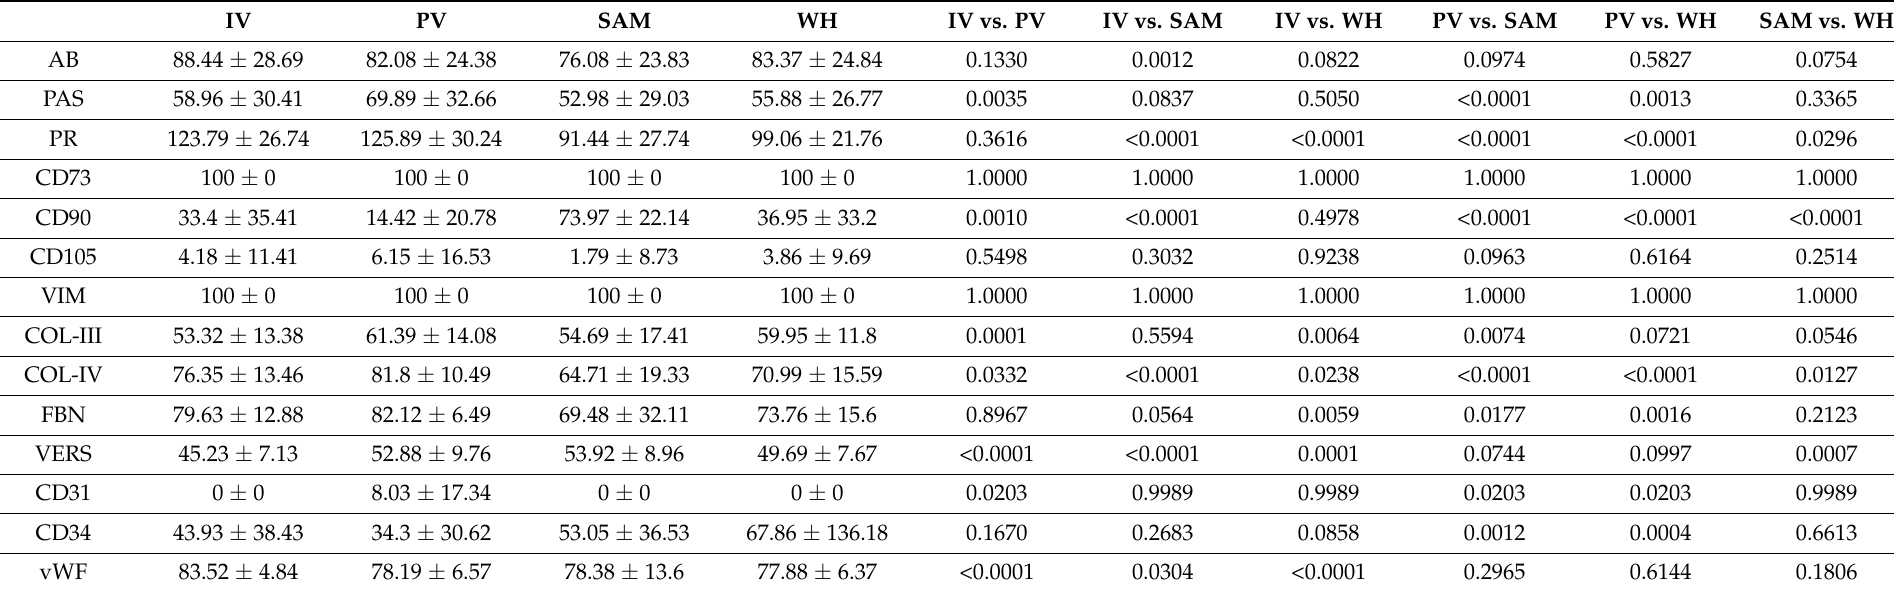
Table 1. Quantitative analysis of the markers analyzed in the present work by histochemistry and immunohistochemistry in each zone of the human umbilical cord (hUC). Average and standard deviations are shown for each zone, and the statistical p values corresponding to the comparison between two specific zones are shown in the columns to the right. IV: intervascular zone; PV: perivascular zone; SAM: subamnioblastic zone; WH: Wharton zone; AB: alcian blue; PAS: periodic acid-Schiff; PR: picrosirius red; VIM: vimentin; COL-III: collagen type III; COL-IV: collagen type IV; FBN: fibronectin; VERS: versican; vWF: von Willebrand factor. For AB, PAS, PR, COL-III, COL-IV, FBN, VERS, and vWF, values correspond to staining intensity units (I.U.), whereas the results shown for CD73, CD90, CD105, VIM, CD31, and CD34 correspond to the percentage of positive